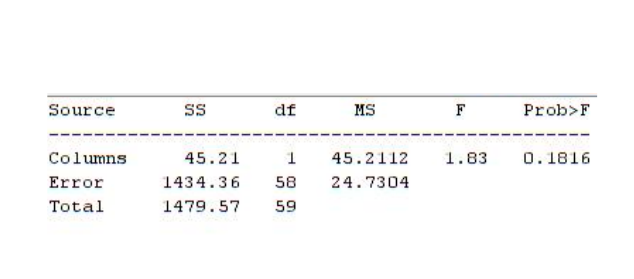
18 of 25 Figure 19. ANOVA test, MAPE indicator. 2.